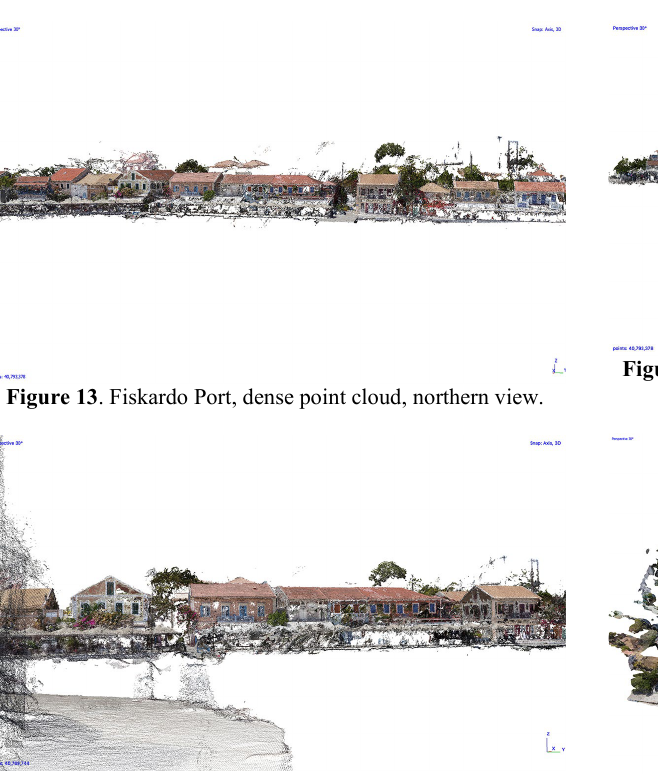
Figure 14 . Fiskardo Port, dense point cloud, view from the dock.